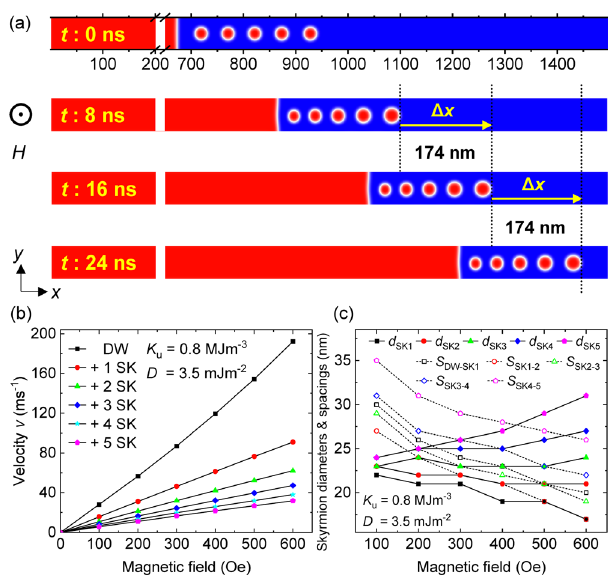
Fig. 3 Field-driven dynamics of a domain wall – skyrmions train. accompanying expansion of the up domain in a positive fi eld ( fi eld strength H = 400 Oe). Here, the train consists of 5 skyrmions. The time after durations ( Δ t : 8 ns, i.e., 8 – 16 and 16 – 24 ns), the ensemble travels equal distances ( Δ x : 174 nm), implying that at time t = 8 ns the steady state has been attained. Consequently, the ensemble velocity can be calculated as v = Δ x / Δ t . b Ensemble velocity against fi eld strength for the number of skyrmions N s = 0, 1, 2, 3, 4, and 5. De fi nitely, an increase in N s leads to a different fi eld strengths for N s = 5. d SK i denotes the diameter of the i